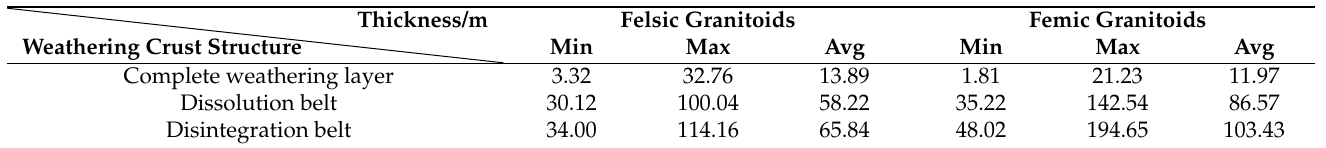
Table 3. Thickness variation of distinct weathering crust structures regarding different lithological components.